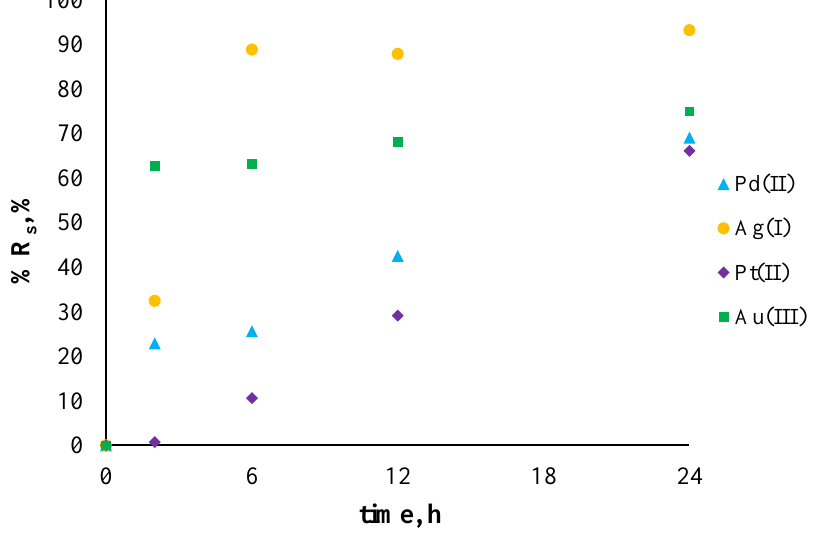
Figure 7. The percentage recovery (%R s ) of metal ions from single-component solutions using polymer membranes containing salen. The given values of %R s carry ±0.01.